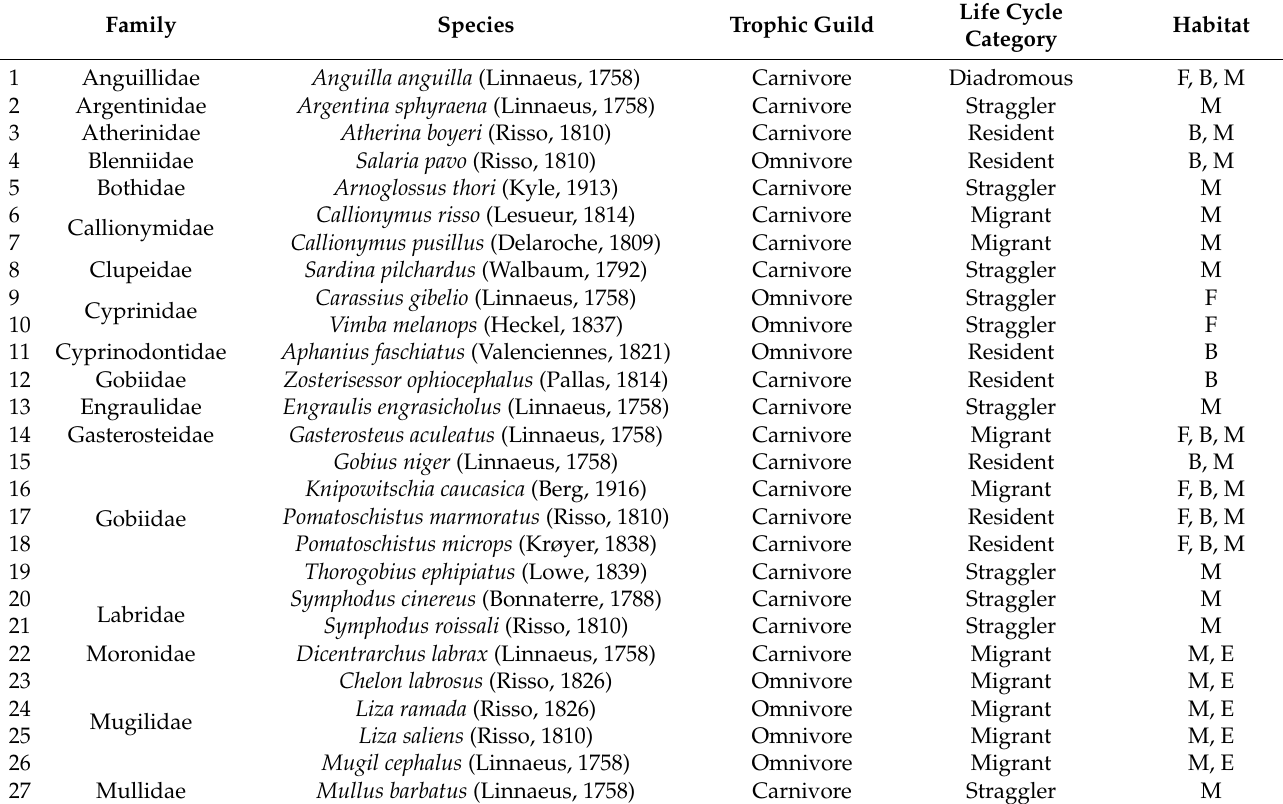
Table 2. The fish species recorded during the samplings conducted in the nine lagoons of East Macedonia and Thrace Region in 2013–2016. The basic traits of each species, i.e., diet, life history, and the habitat they prefer (F = Freshwater, B = Brackish, M = Marine), as they are depicted in www.fishbase.se (accessed on 10 February 2021), are also